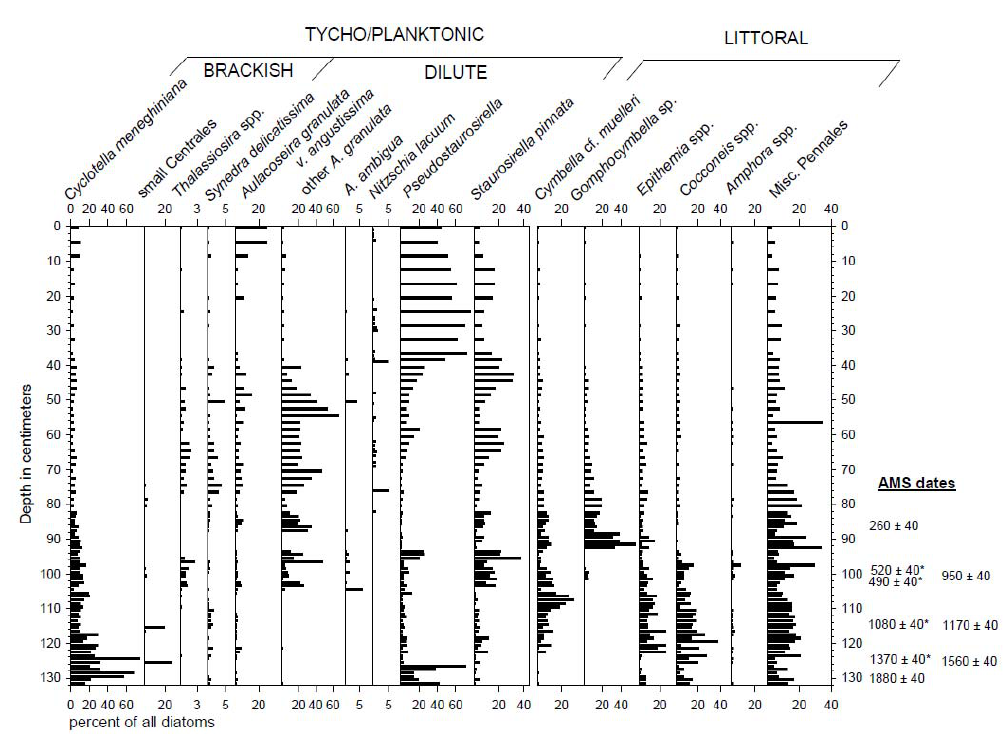
Fig. 6. Diatom assemblages in core VV09 versus depth, with AMS dates on plant remains (with asterisk) and bulk sediments.